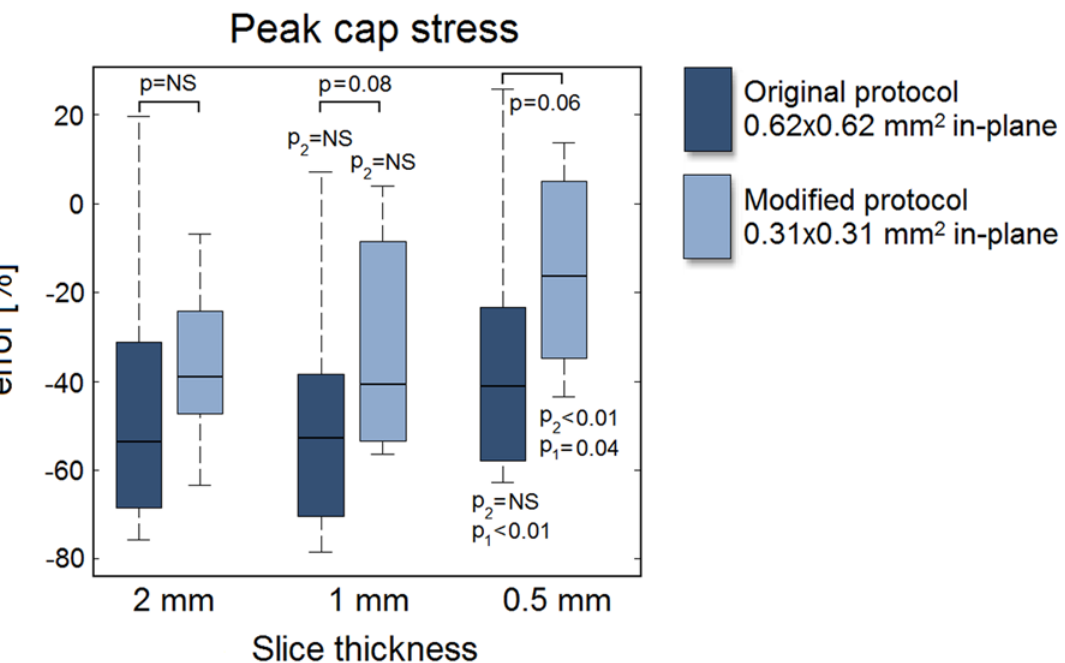
Fig 7. Relative error in the MRI segmentation model predicted peak cap stress with respect to the ground truth peak cap stress as a function of slice thickness. For details, see caption of Fig